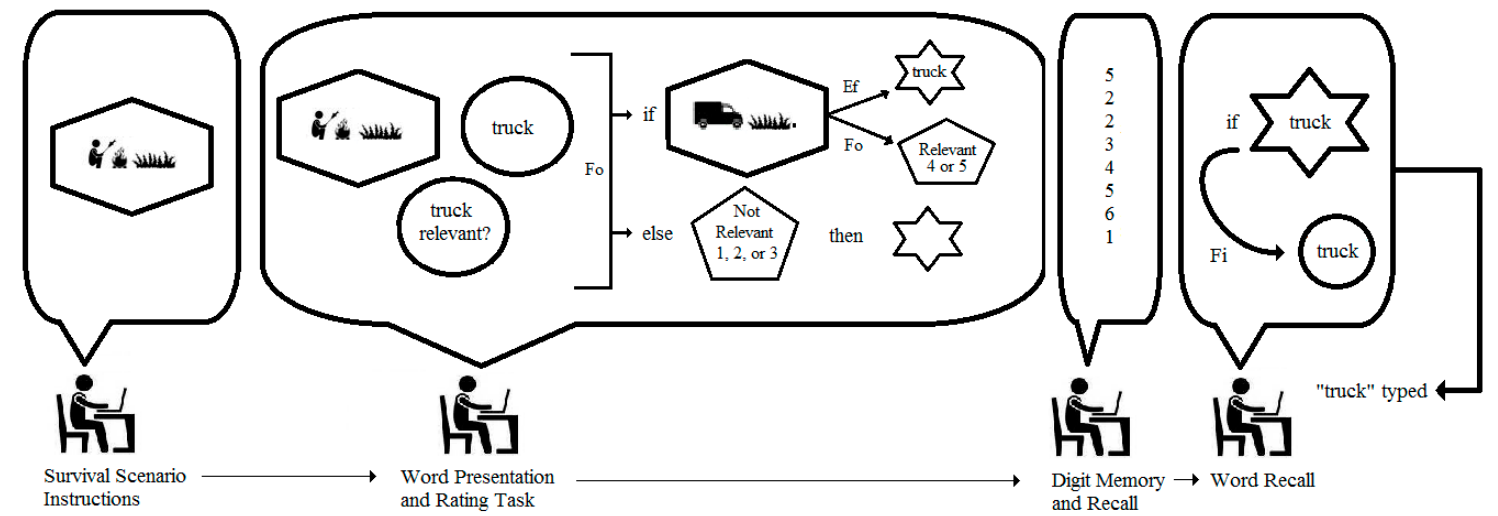
Figure 5. Model representing integration of “truck” into imagined scene of survival. Visual images are represented as elongated hexagons; simple predication is represented as a circle; complex judgments are represented as pentagons; memory storage is represented as hexagrams; “if” and “else” represent standard logical operators; “Ef” represents an efficient cause; “Fo” represents a formal cause, and “Fi” represents a final cause.